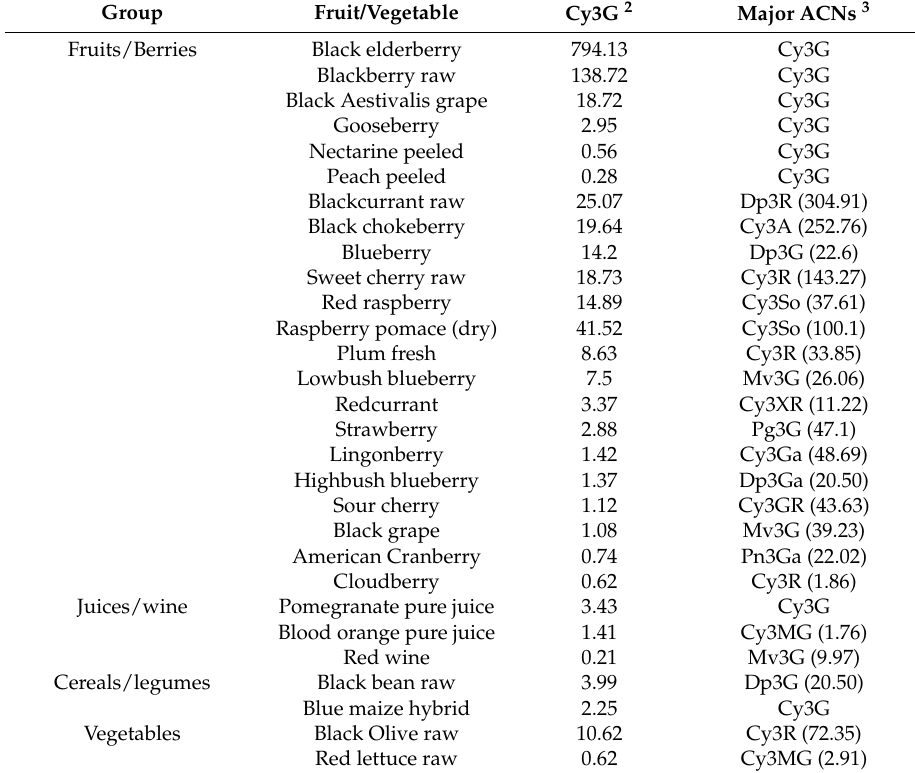
Table 3. Cyanidin-3- O -glucoside (Cy3G) content in selected edible sources 1